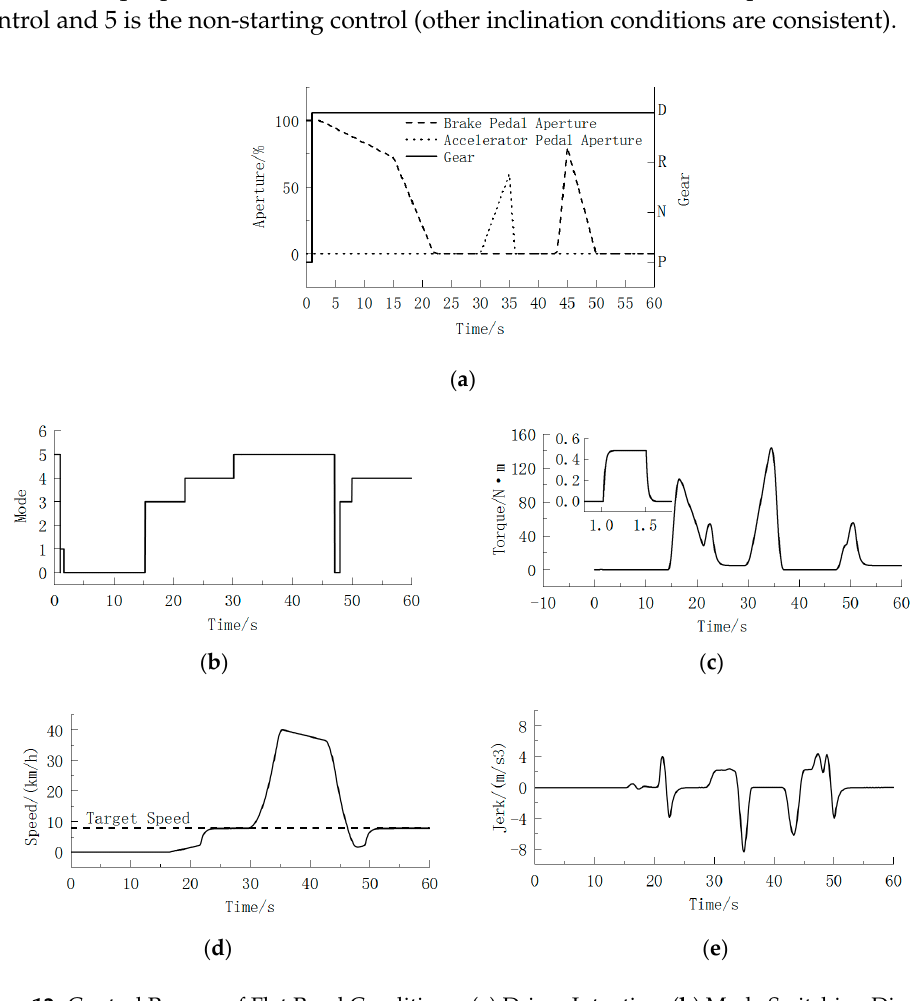
Figure 12. Control Process of Flat Road Conditions: ( a ) Driver Intention; ( b ) Mode Switching Diagram; ( c ) Curve of Motor Output Torque; ( d ) Curve of Vehicle Velocity; ( e ) Curve of Jerk.